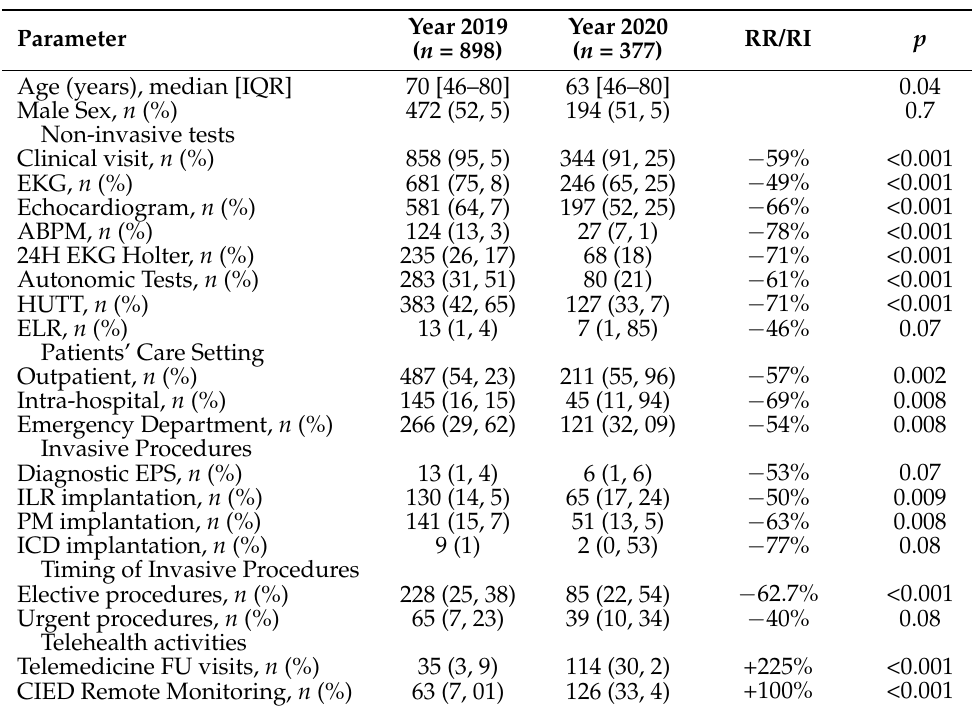
Figure 5. Number and type of telehealth activities during 2019 and 2020 study periods. FU: follow-up; CIED: cardiac implantable electronic device. Table 1. Anthropometric characteristics and differences in SUs activities during 2019 and 2020 study